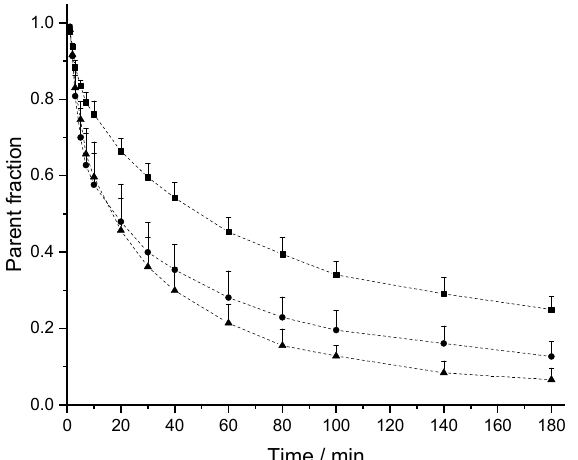
Figure 3. Plasma kinetics of [ 18 F]CPFPX (triangles), [ 18 F]CBX (squares) and [ 18 F]MCBX (circles) in rat after i.v. bolus administration. The standardized uptake value (SUV) was calculated by normalizing the plasma radioactivity concentration to the amount of injected radioactivity and body weight. Solid lines represent the triexponential model fits. Data (mean ± SD) were obtained from eight ([ 18 F]CBX, [ 18 F]CPFPX) or nine animals ([ 18 F]MCBX).